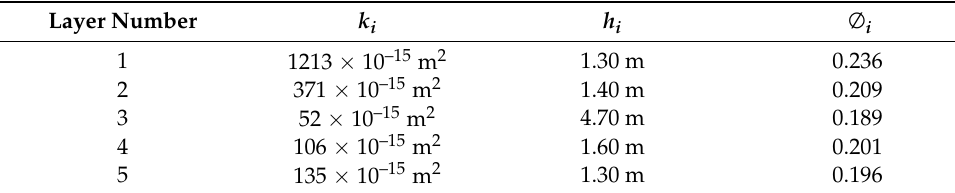
Table 1. Parameters of the model reservoir layers.